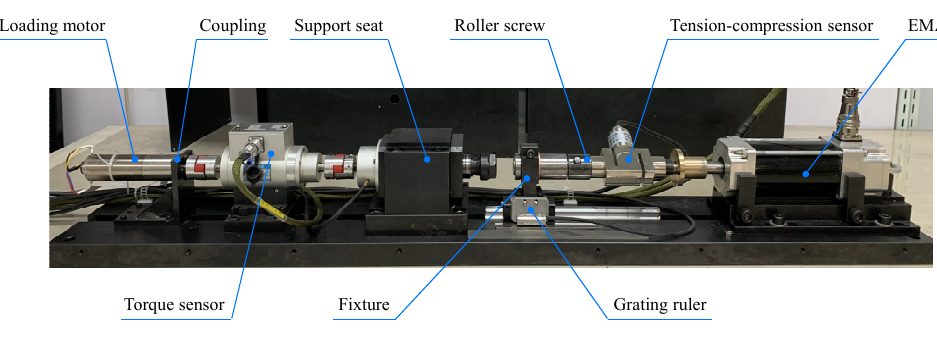
Figure 4. Photograph of Test Rig.